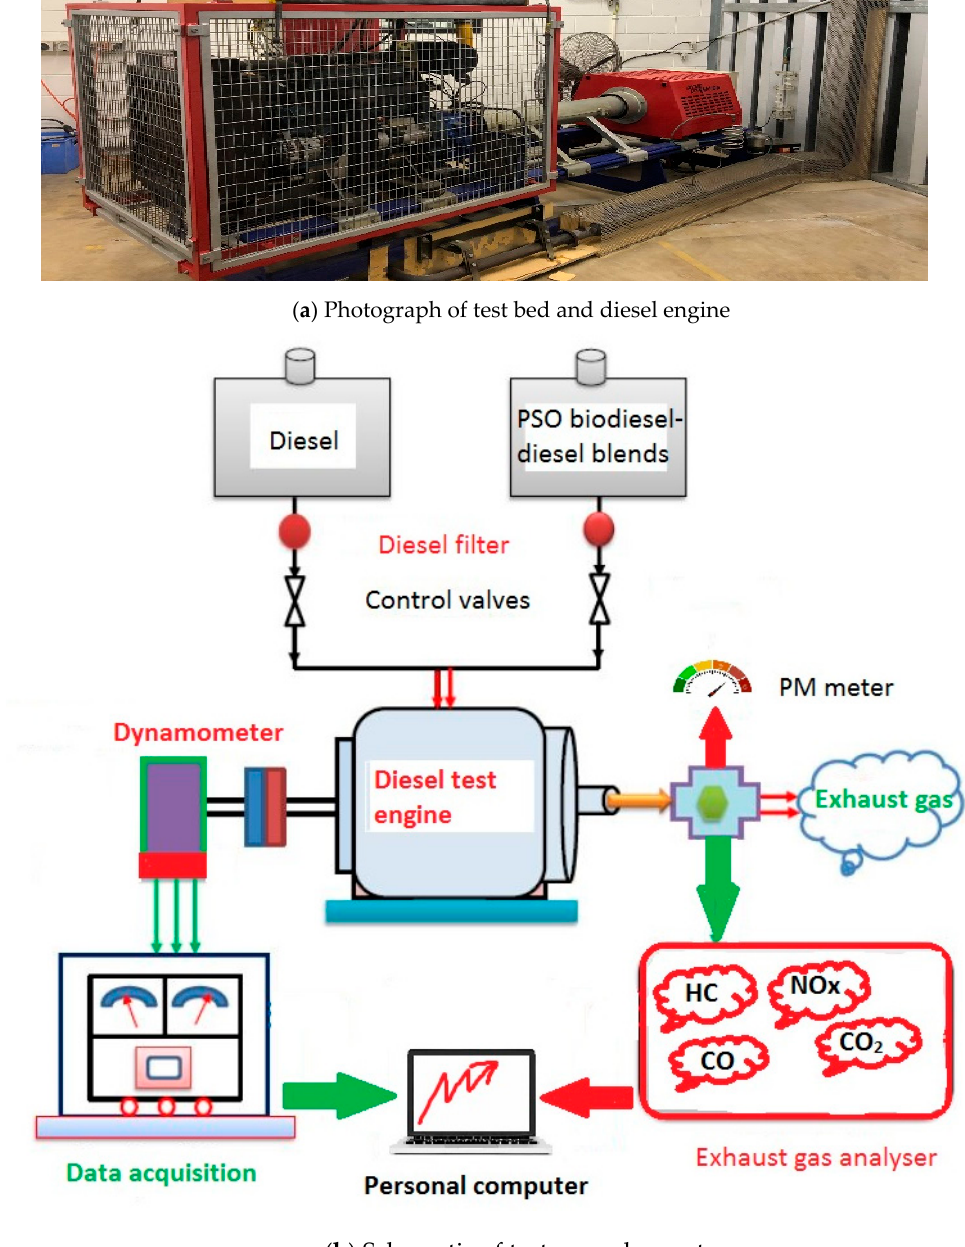
Figure 3. Test engine set up. Table 5. Details of the test engine.